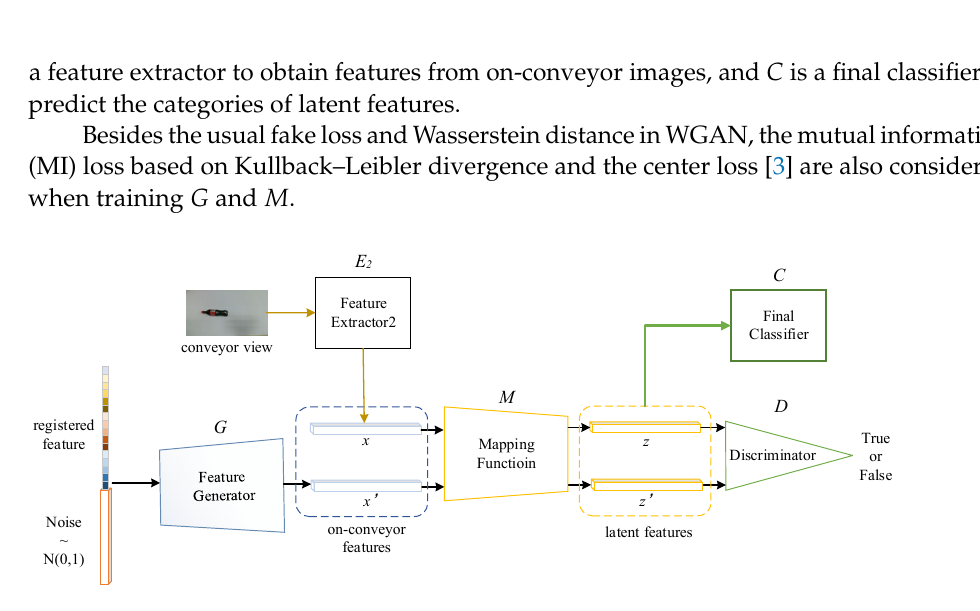
Figure 6. Structure of the feature mapping module.